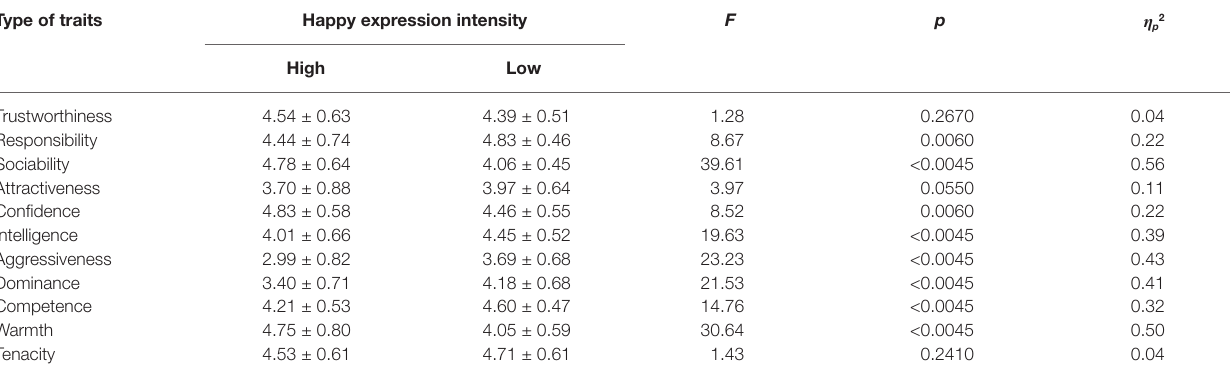
TABLE 4 | Evaluation scores for the different social traits under high- and low-intensity happy expressions (M ± SD). Type of traits